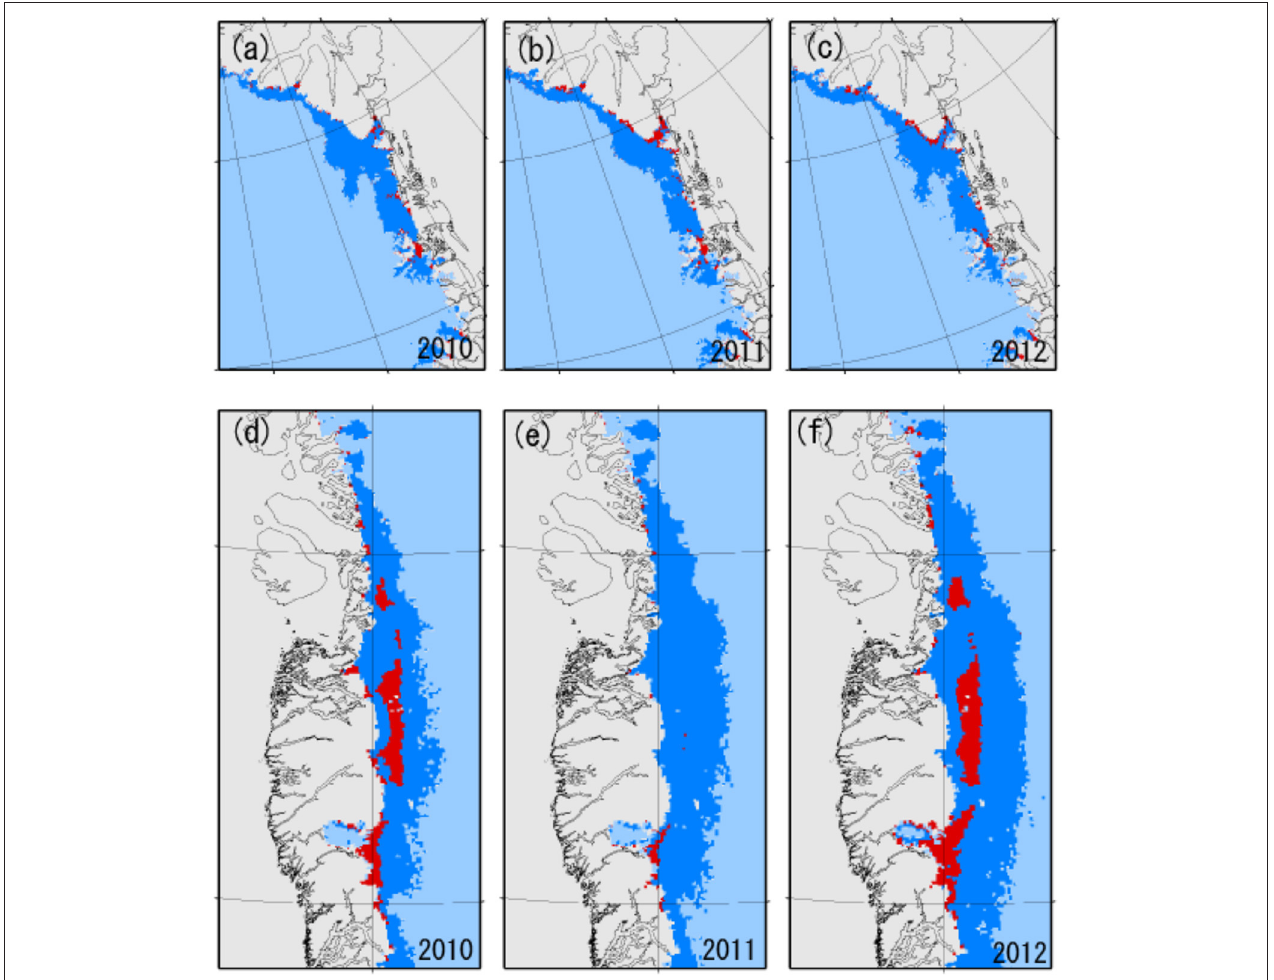
FIGURE 6 | Distribution of snow (light blue), bare ice (blue), and dark ice (red) in northeastern region (A–C) and southwestern region (D–F) during July from 2010 to